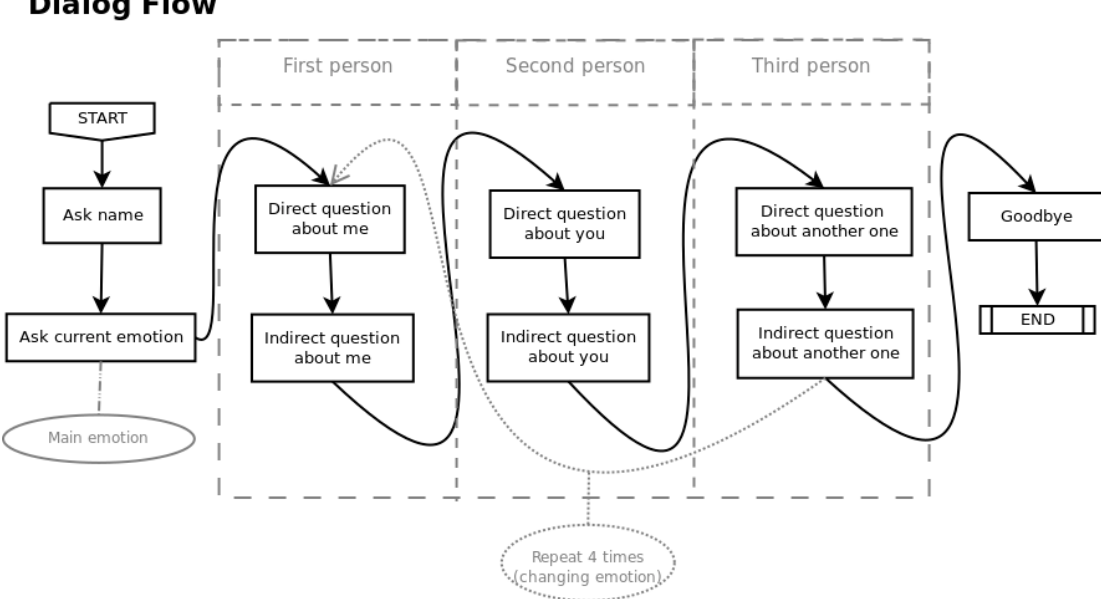
Figure 4. Conversation flow where each main phase consists of 6 questions about emotional states in different situations, including direct and indirect questions, apart from the starting and ending